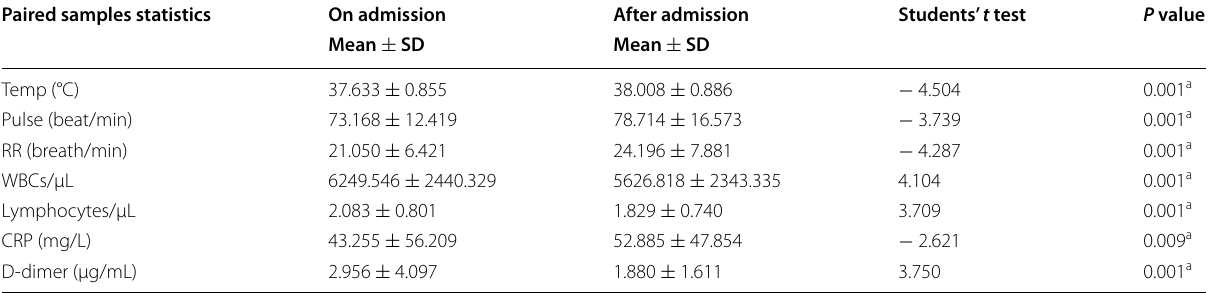
SD standard deviation, WBCs = a Significant